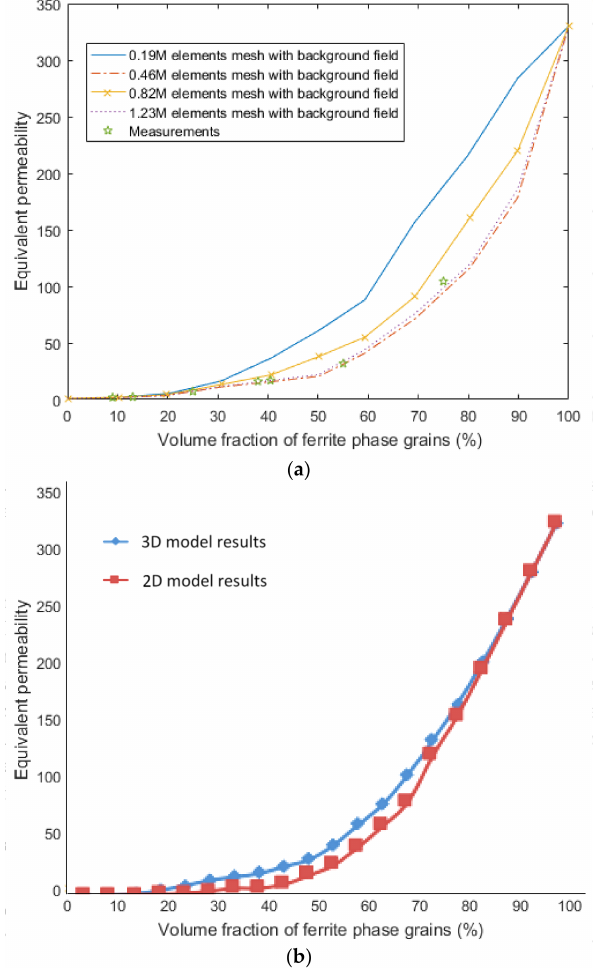
Figure 9. ( a ) Measurements and equivalent relative permeability of austenite–ferrite in the RCPS-VM microstructure with varying phase fractions when the model is meshed into 0.19 M, 0.46 M, 0.82 M, and 1.23 M elements. ( b ) Equivalent relative permeability of austenite–ferrite in 2D and 3D EM models using COMSOL